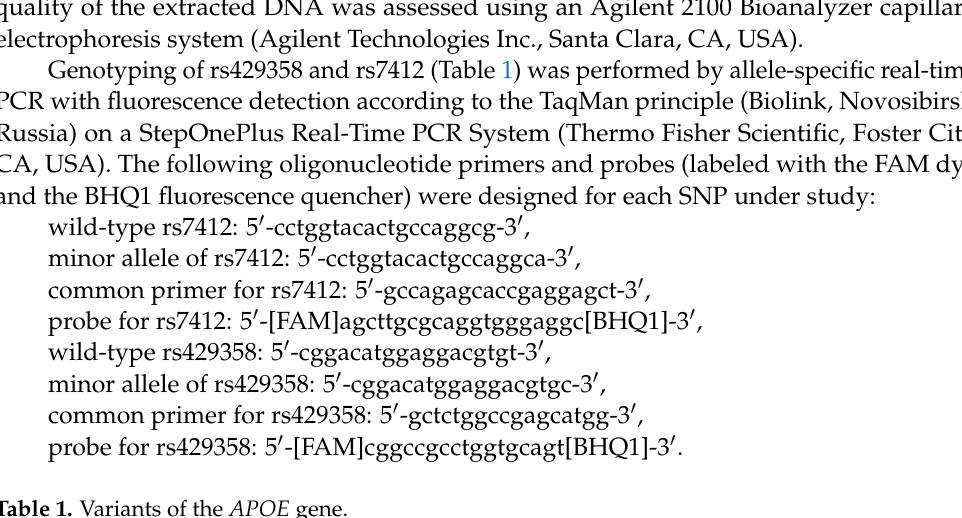
Table 1. Variants of the APOE